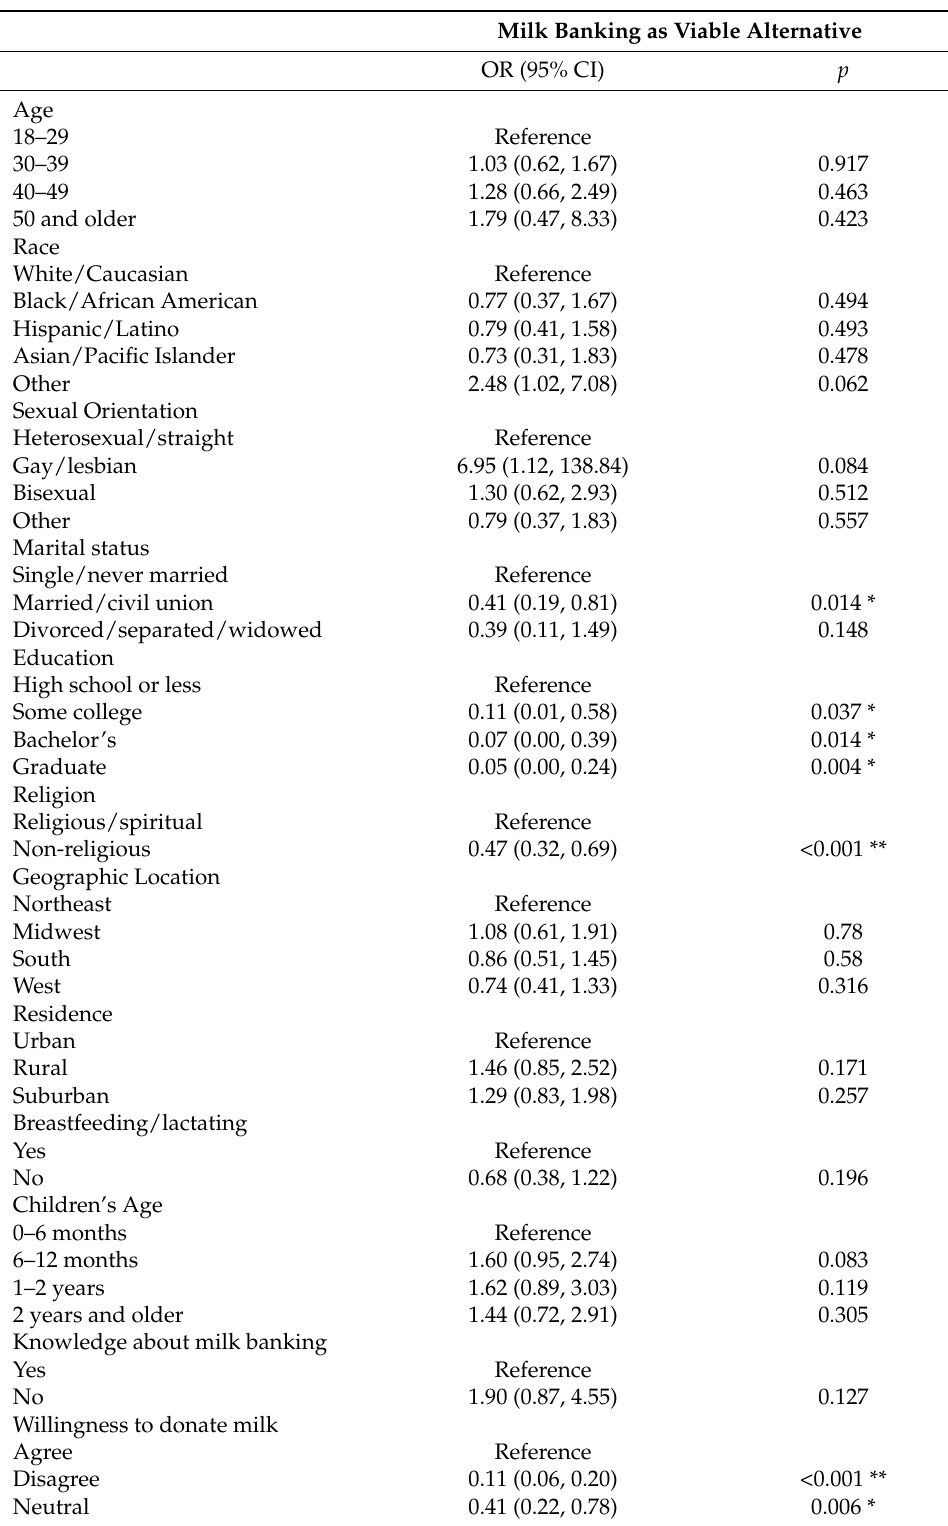
Table 3. Results of logistic regression for milk banking as viable alternative ( N =